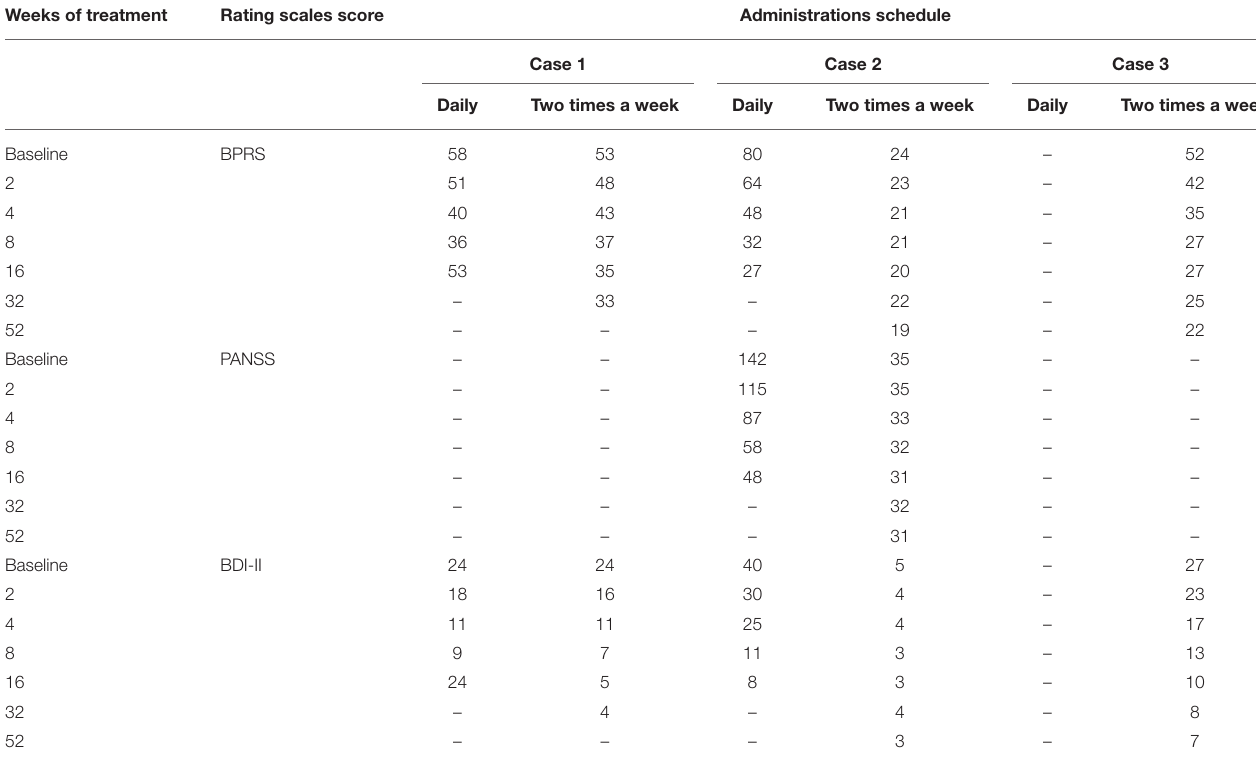
TABLE 1 | Response to CAR treatment. Weeks of